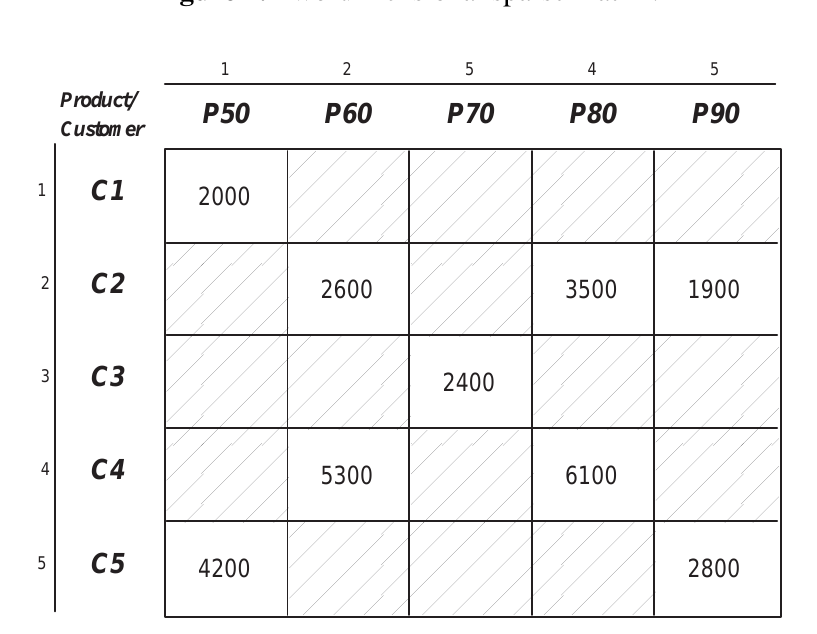
Figure 1. Two-dimensional sparse